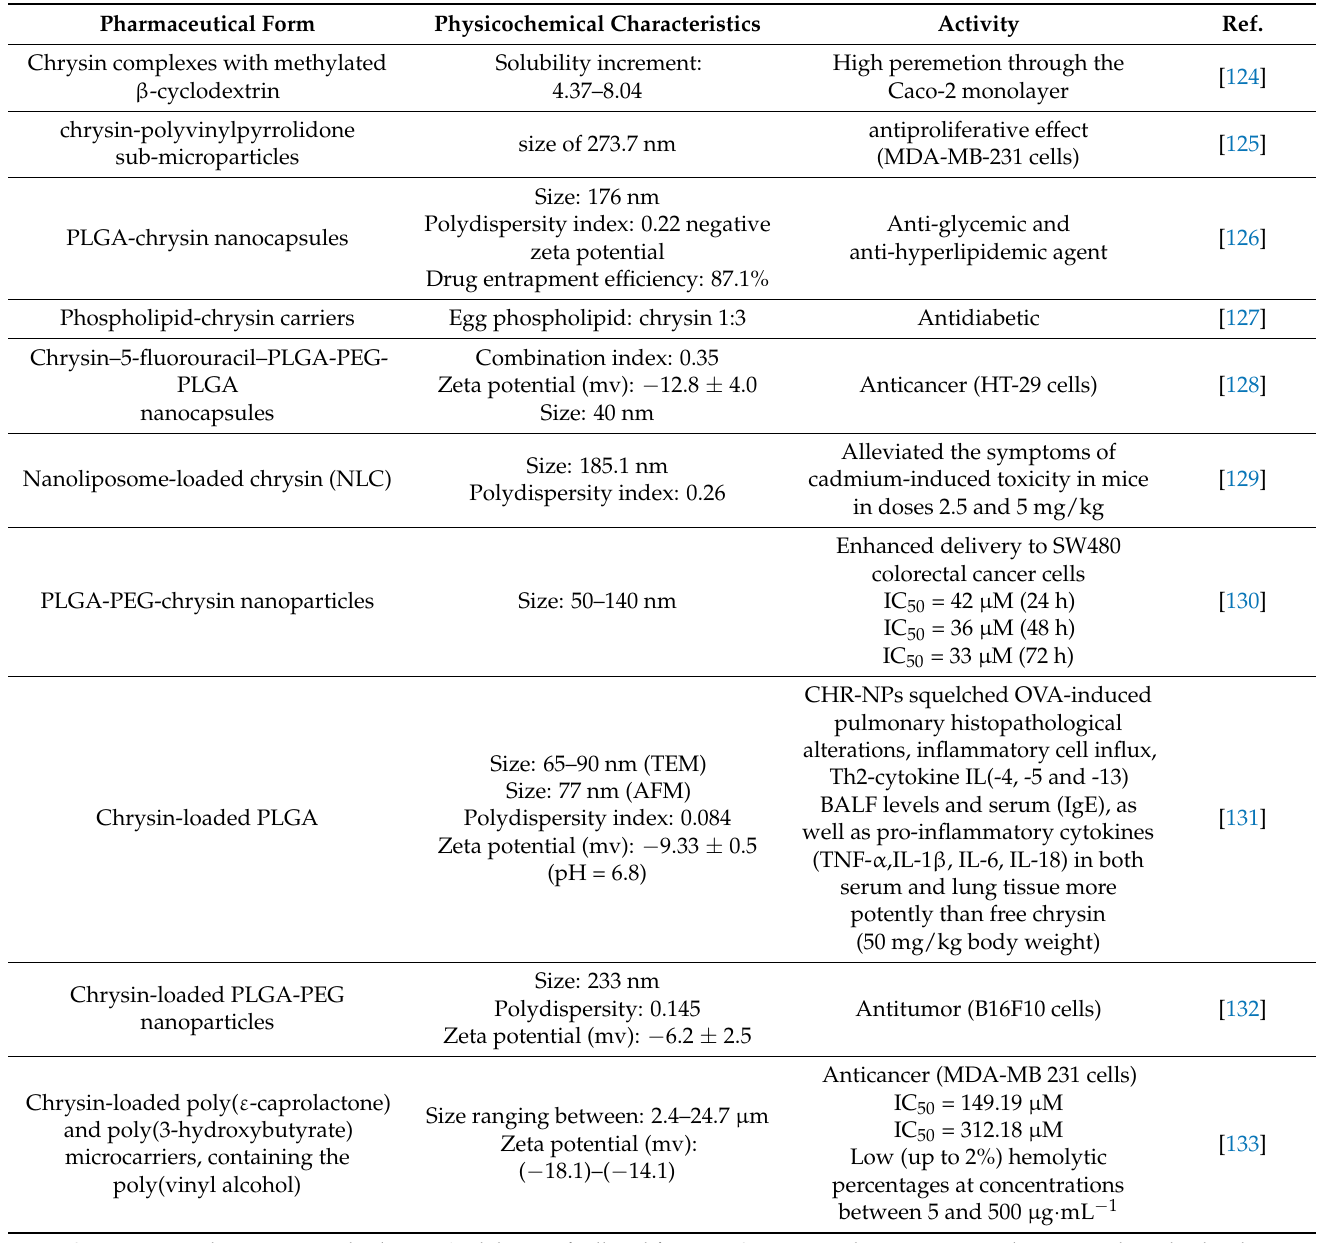
Table 3. New chrysin delivery